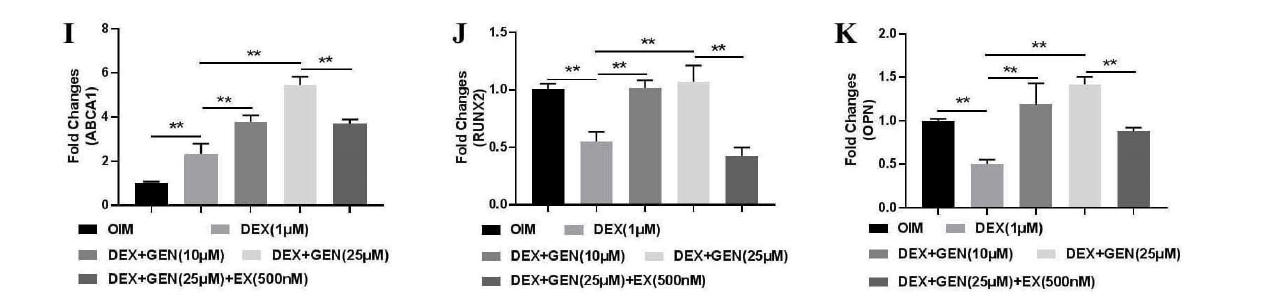
Figure 5. GEN promoted ABCA1-mediated cholesterol metabolism in a GLP-1R-dependent manner. ( A , B ) The in vivo immunohistochemical examination of GLP-1R expression was conducted. ( C , D ) The protein expression of GLP-1R was determined by western blot in DEX-treated MC3T3-E1 cells. ( E ) The ALP staining and the Alizarin Red S staining assay were performed in EX-treated MC3T3-E1 cells ( × 100 magnification). ( F ) The level of the total intracellular cholesterol was measured using the ELISA kit. ( G – K ) The protein expression of GLP-1R, ABCA1, RUNX2, and OPN was detected by western blot. All experiments were implemented separately in triplicate. * p < 0.05; ** p < 0.01. NC, negative control; 50 mg/kg, Dex + 50 mg/kg GEN; 100 mg/kg, Dex + 100 mg/kg GEN; EX,